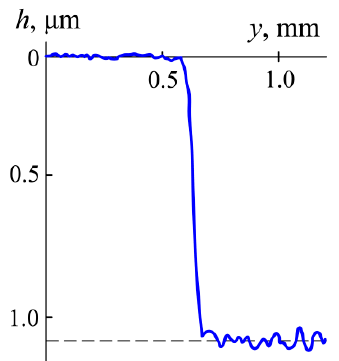
Figure 3. Profilogram of an Al 2 O 3 substrate surface bombarded with a mask by fast argon atoms.